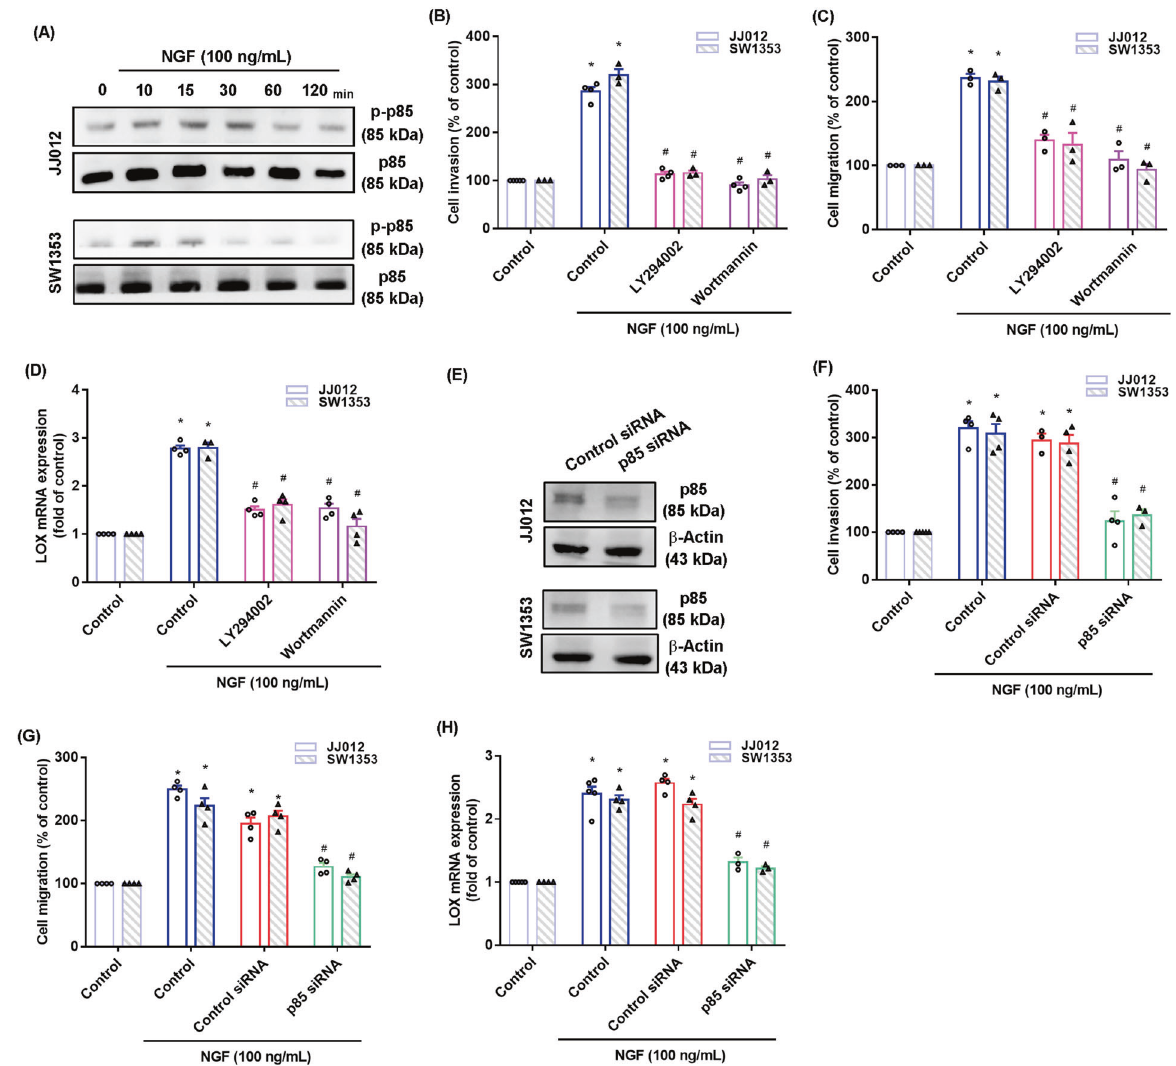
Fig. 2 The PI3K pathway mediates NGF-induced LOX expression and cell motility. A Cells were incubated with NGF for the indicated time intervals; p85 phosphorylation was examined by western blot. B – D Cells were treated with PI3K inhibitors (Ly2942002 and wortmannin)